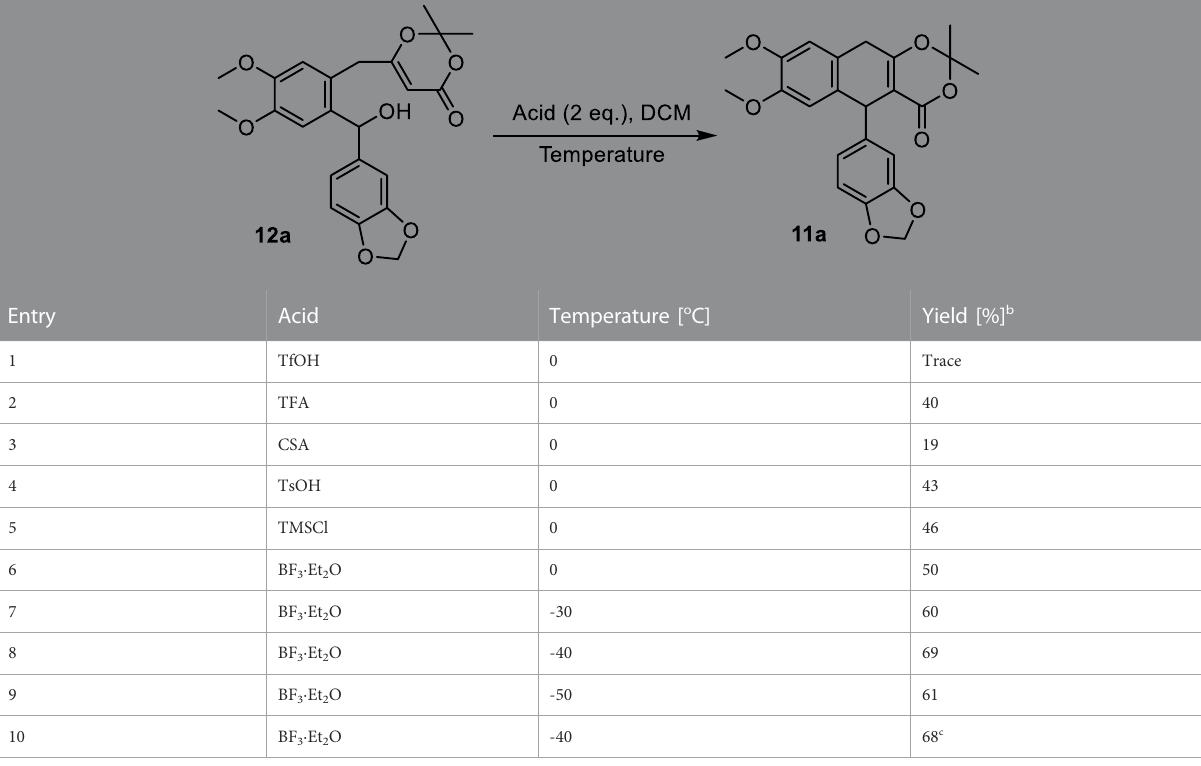
TABLE 2 Optimization for the intramolecular cation-induced cyclization a .